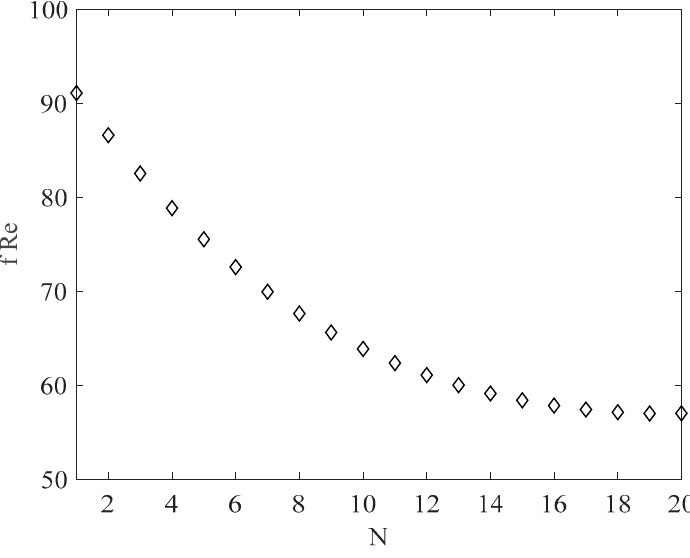
Figure 6. f Re as a function of the number of rectangular channels.